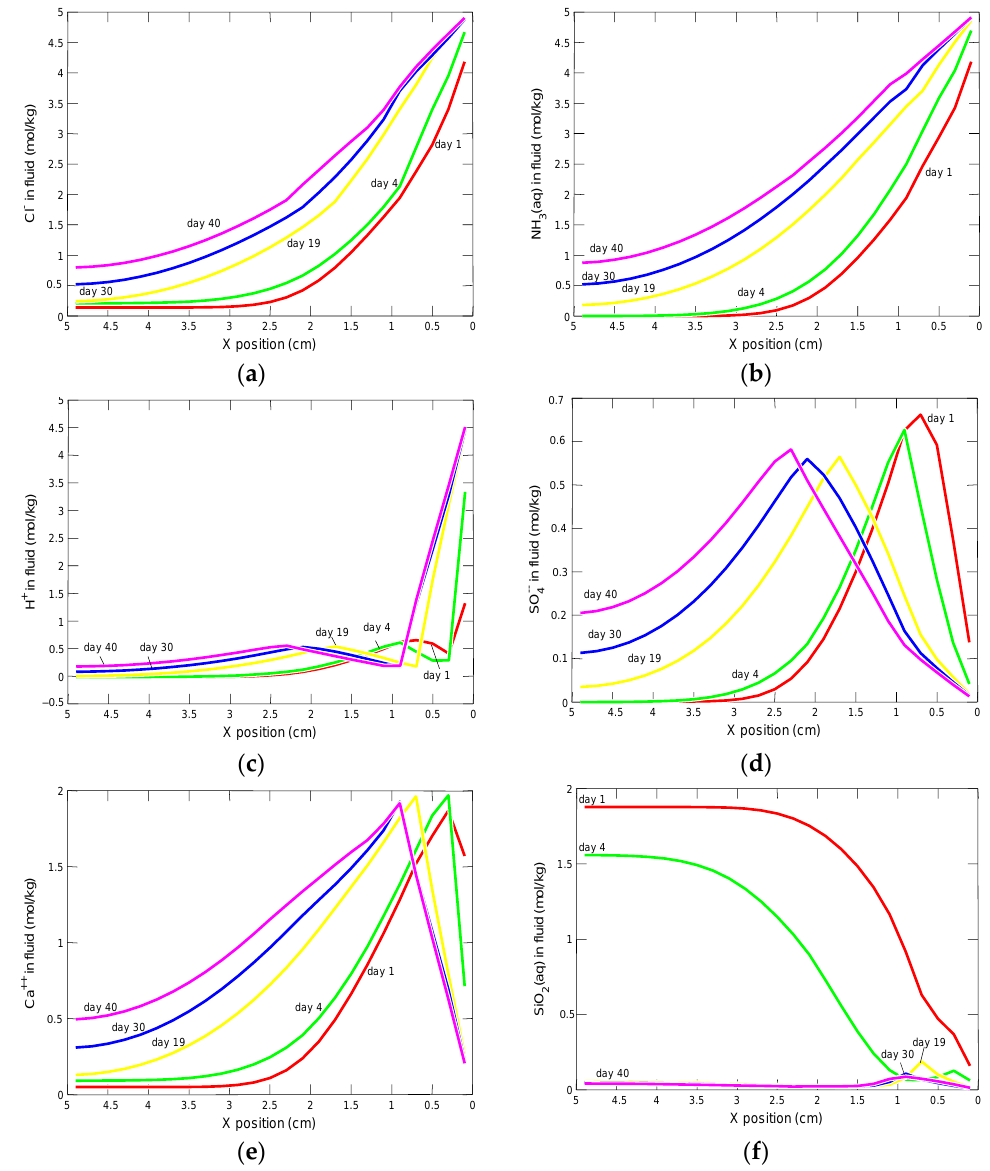
Figure 18. Profiles of changes in the concentrations of the components of the pore solution in the model domain, after 1, 4, 19, 30 and 40 days from the beginning of the experiment, for: ( a ) chlorides, ( b ) ammonia, ( c ) hydrogen, ( d ) sulphates, ( e ) calcium and ( f ) silica.